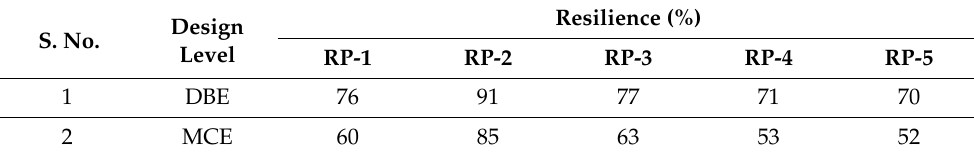
Table 18. Seismic resilience of unsymmetrical building under bidirectional loading (Case III). Design S. No.